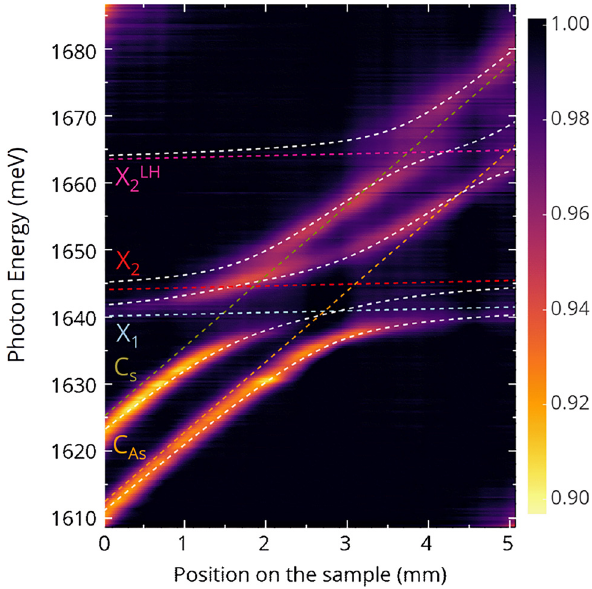
Figure 2: Reflectivity spectra of the vertically coupled, double microcavities, registered as a function of the detuning between the microcavities’ coupled modes and QW excitons. The lines, as indicated by the labels, describe the bare levels of the heavy hole and X in the (Cd,Zn,Te) QWs and (Cd,Zn,Te):Mn QWs, excitons X 1 2 respectively; the light-hole exciton X LH in the (Cd,Zn,Te):Mn QWs, as 2 well as the asymmetric C and symmetric C modes of the coupled AS S microcavities. White, unlabelled lines represent calculated polariton